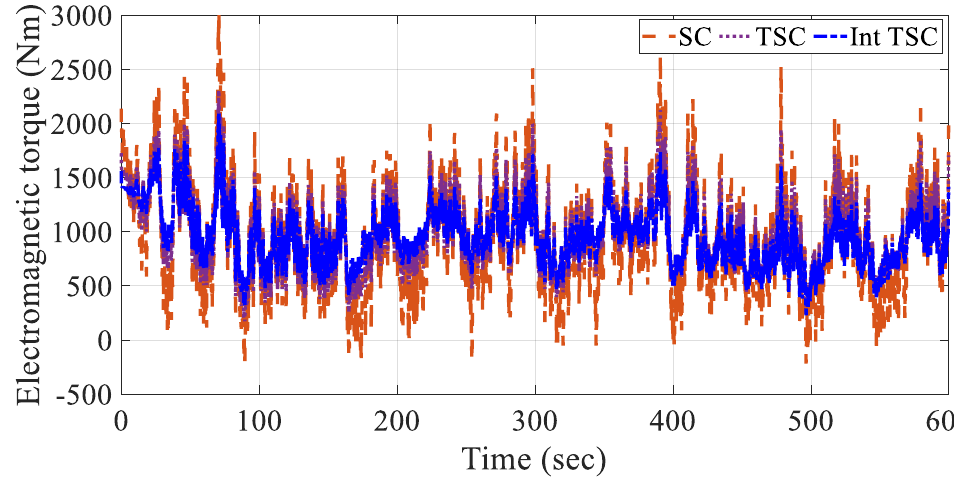
Figure 8. Comparison of generator torques for SC, TSC and Int TSC.